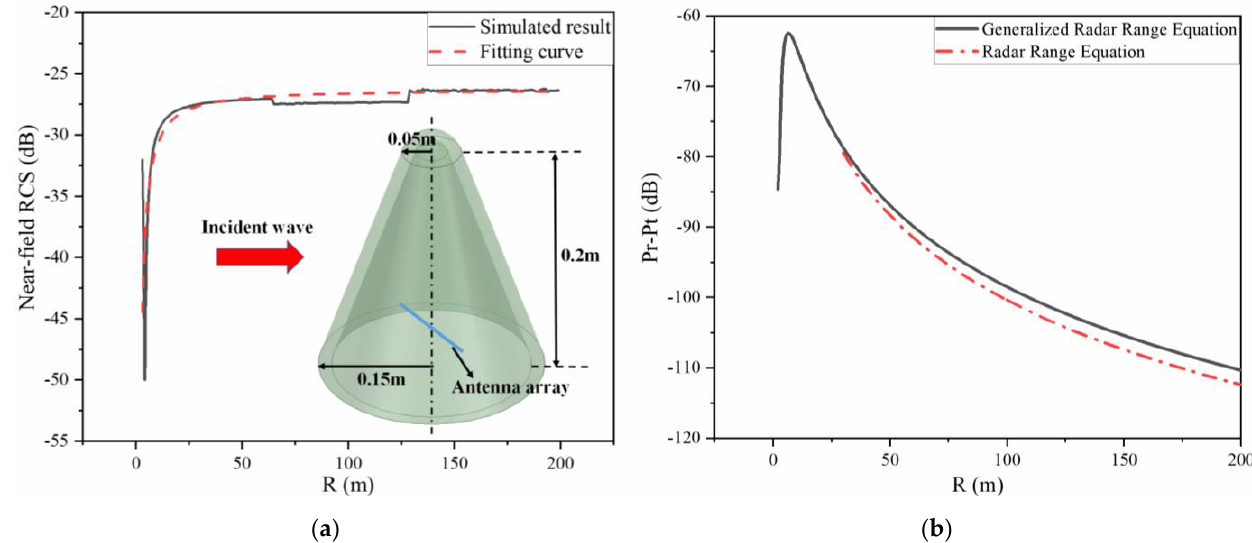
Figure 7. ( a ) Near-field RCS results for high-order spherical cone radome. ( b ) Calculation result of Equation (13).